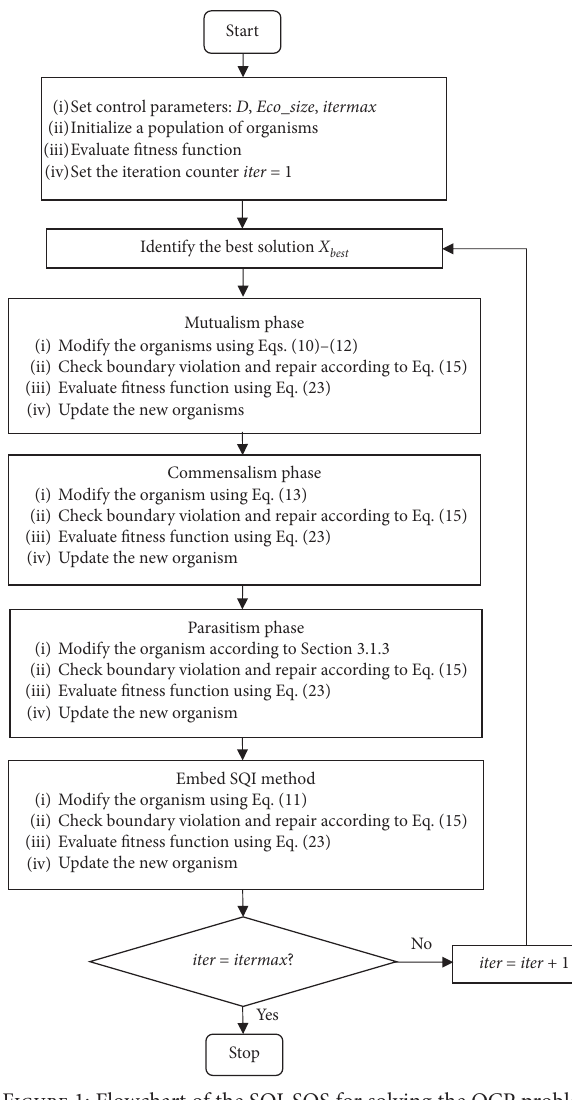
Figure 1: Flowchart of the SQI-SOS for solving the OCP